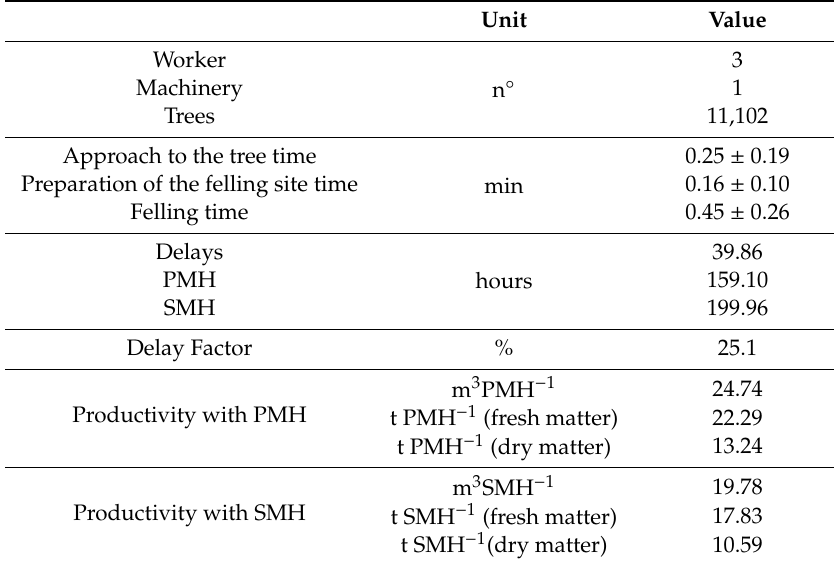
Table 6. Time and productivity of felling operation (average ± standard